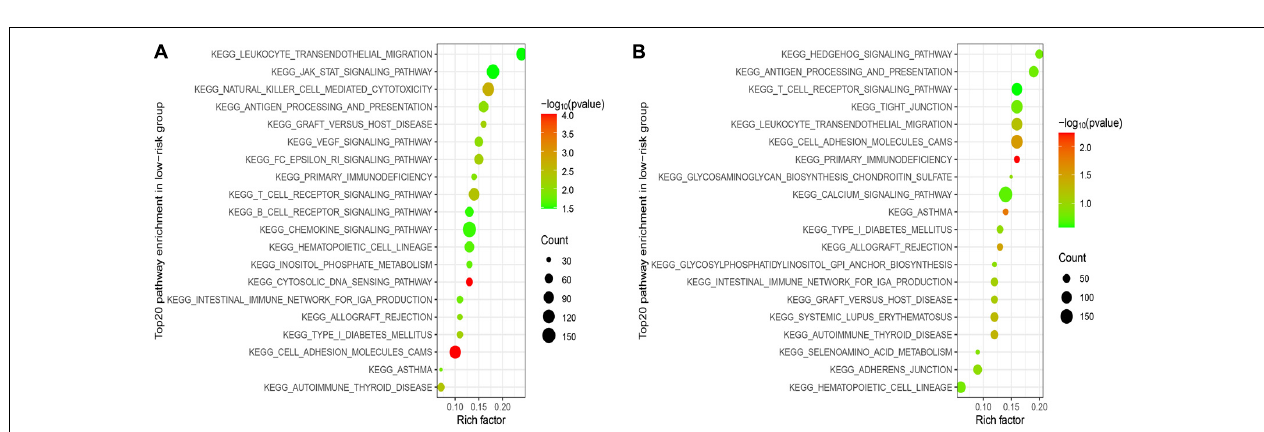
FIGURE 5 | Construction and validation of the nomogram to predict the overall survival in the training cohort. (A) Nomogram built based on TNM stage and risk score in the training cohort. (B) Calibration plot of the nomogram. (C–E) Time-dependent ROC curves of nomograms were compared based on 1- (C) , 3- (D) , and 5-year (E) OS in the training cohort.